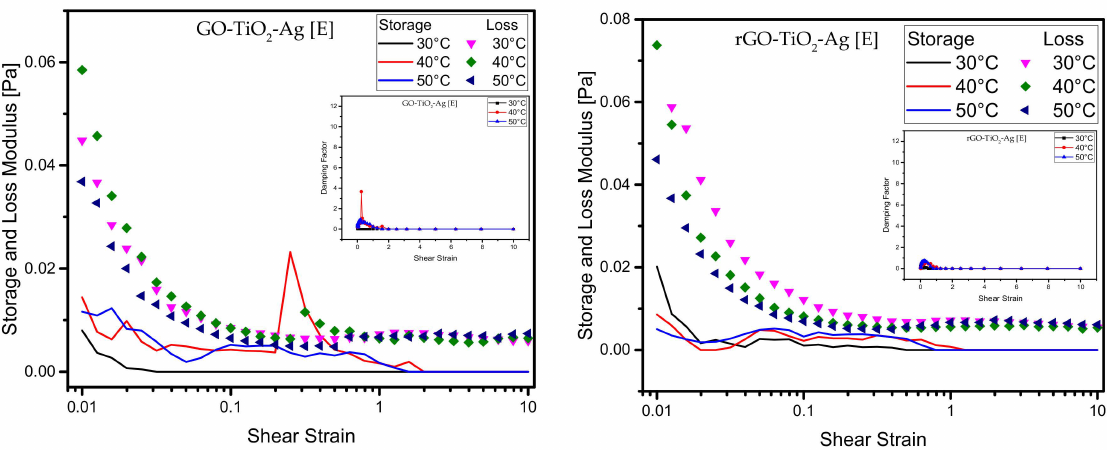
Figure 6. Amplitude sweep—storage modulus and loss modulus vs. shear stress and their damping factor (inset) at different temperatures of ternary hybrid nanoparticles. ( A – E ) are serial